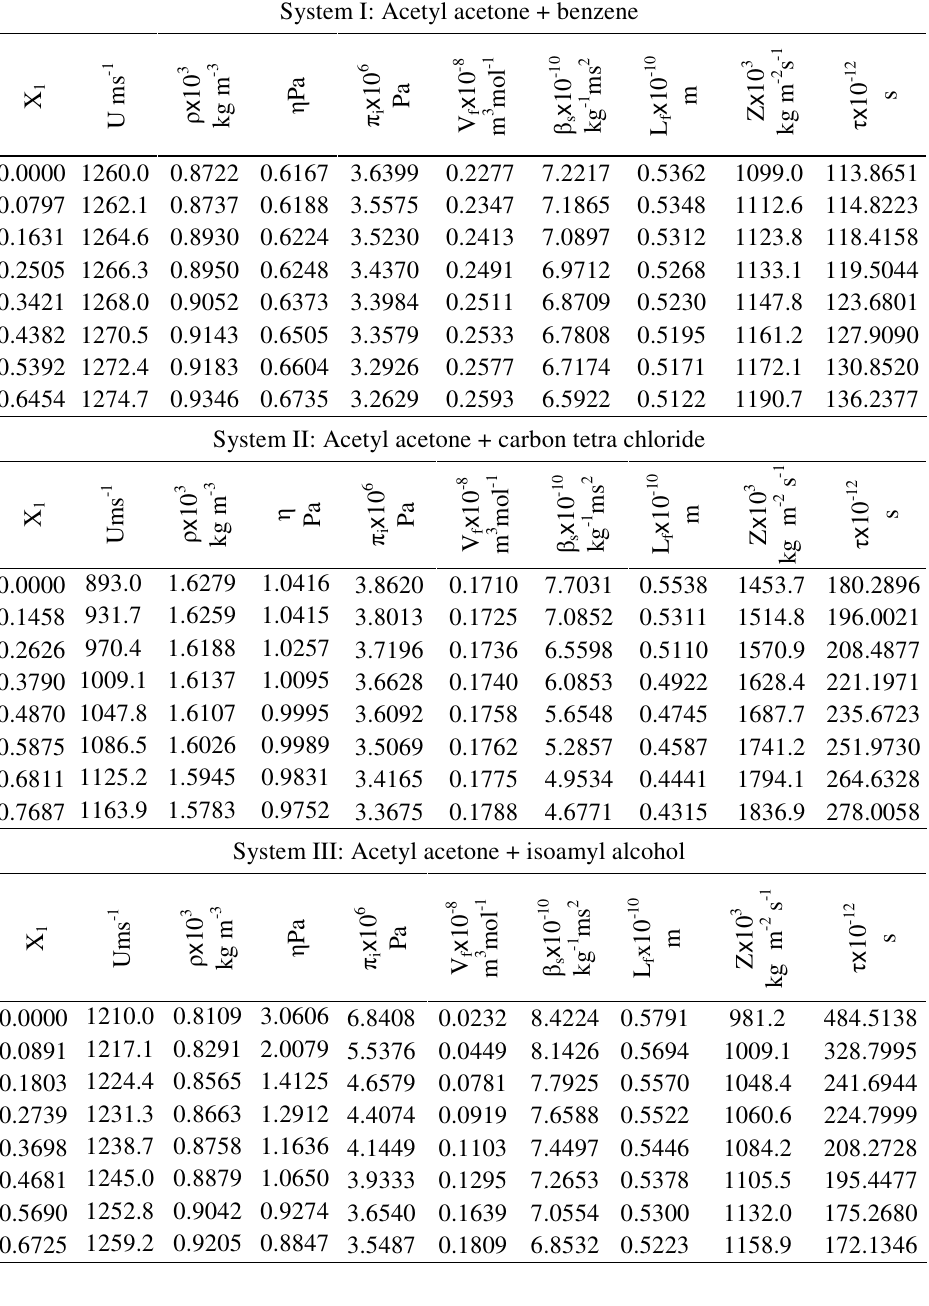
), free length ( L ), acoustic impedance (Z) and relaxation time ( τ ) f s